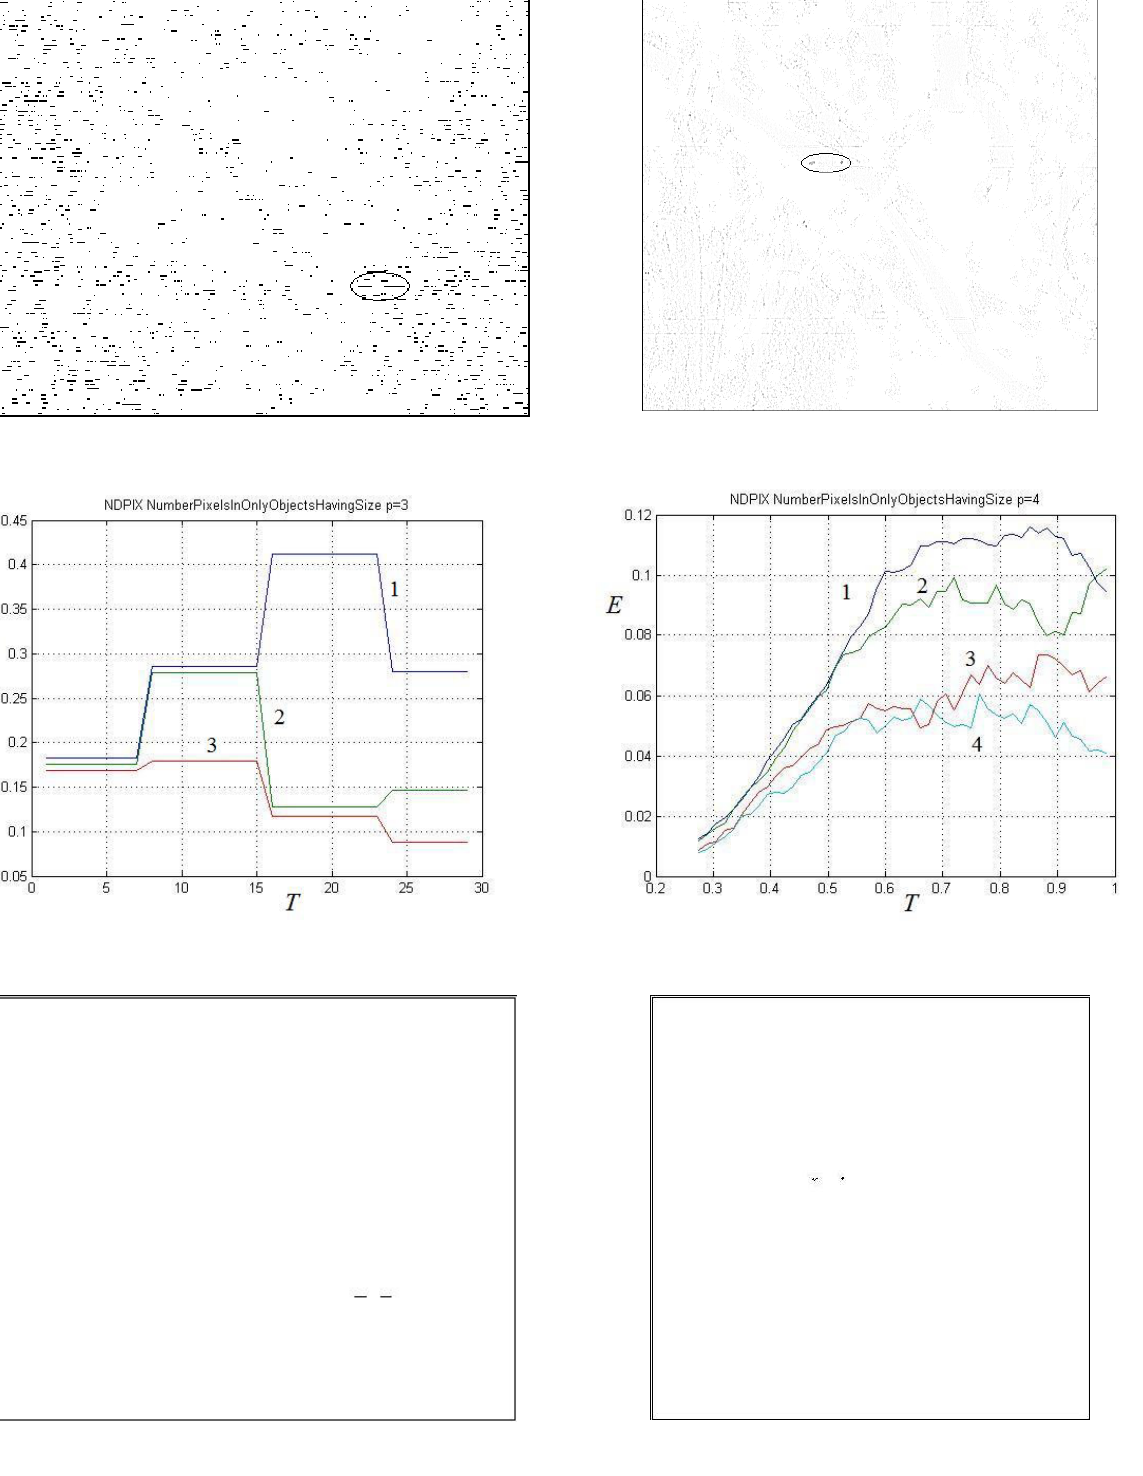
Figure 16. Extraction of small-scale objects from the image in Fig. 1